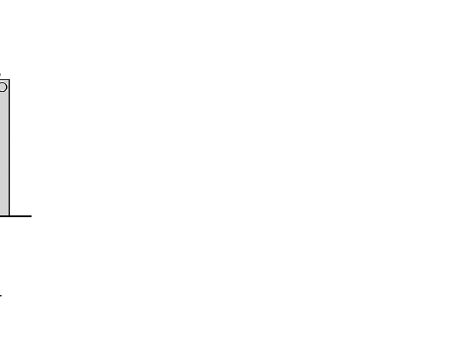
Figure 1. A correct version of Figure